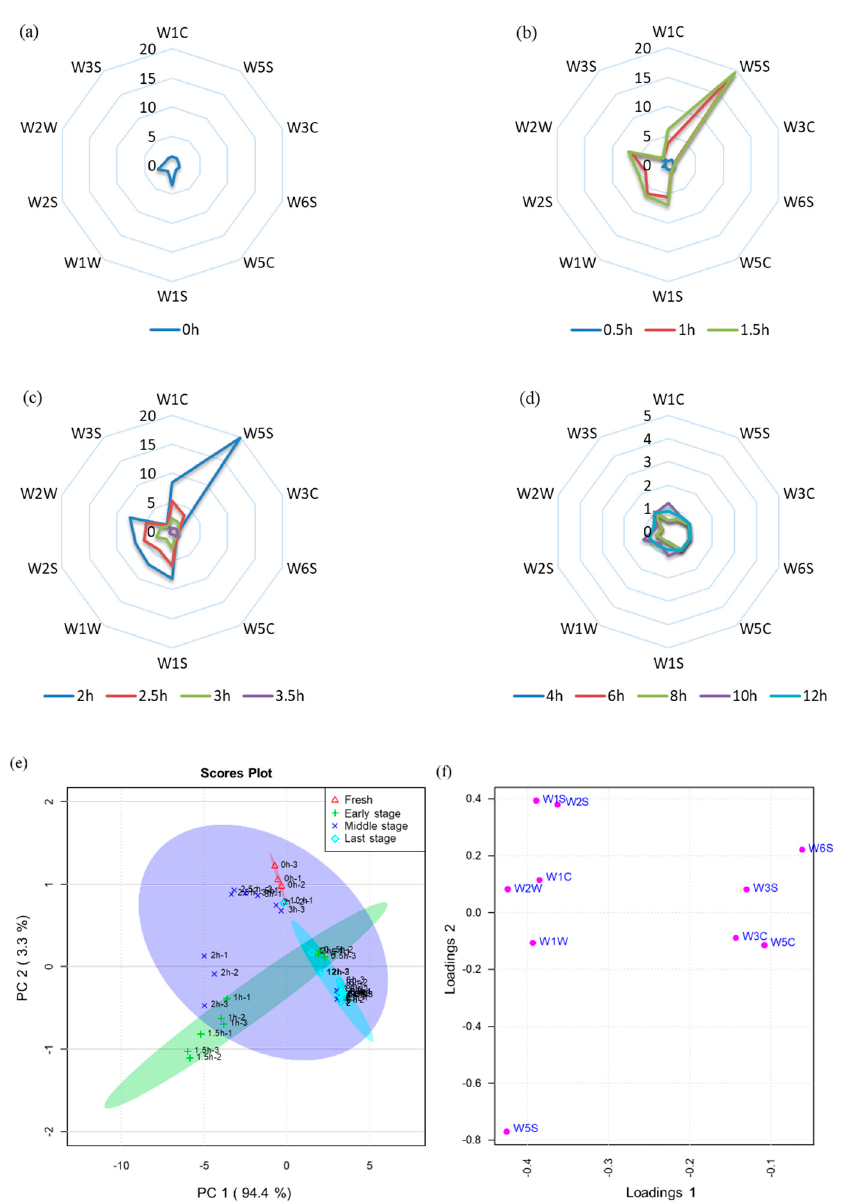
Figure 3. ( a – d ) radar fingerprint of electronic nose in L. edodes at di ff erent drying times; ( e ) PCA scores Figure 3. ( a ), ( b ), ( c ) and ( d ) radar fingerprint of electronic nose in L. edodes at different drying times; scatter plot; ( f ) Loading plot of ( e ) PCA scores scatter plot; ( f ) Loading plot of PCA.